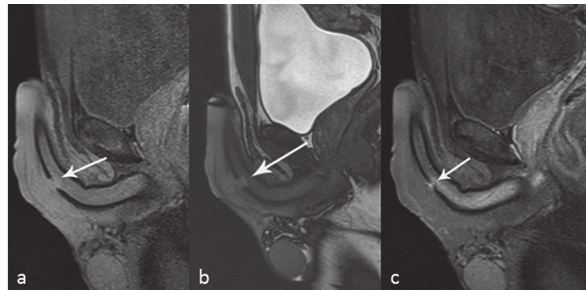
Figure 4 - A 30-year-old patient with penile fracture of the right corpus cavernosum. (a) Sagittal T1-weighted image shows a rupture of the tunica albuginea (arrow). (b) The lesion of the tunica albuginea and soft tissue haematoma surrounding the corpus cevarnosum can be detected on T2-weighted images (arrow). (c) Eight weeks later after surgery, the tunica albuginea in healing process showed heterogeneous signal on unenhanced T1-weighted image